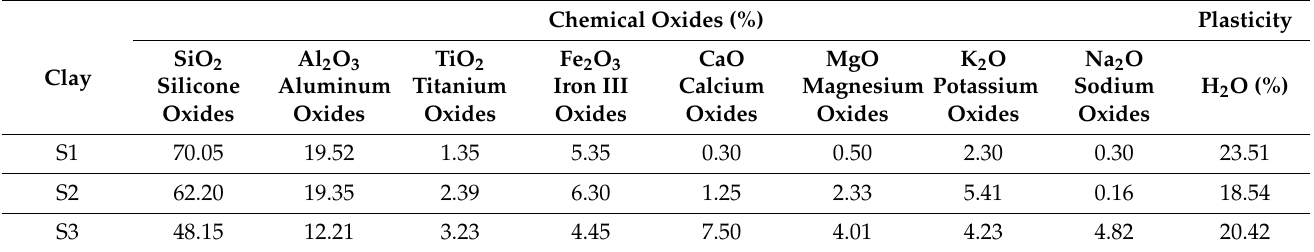
Table 1. Chemical composition and plasticity of clay specimens S1, S2, and S3.